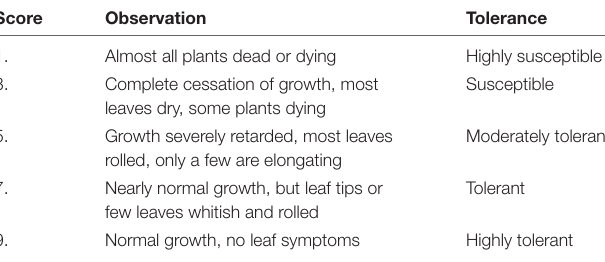
TABLE 1 | The standard evaluation score (SES)